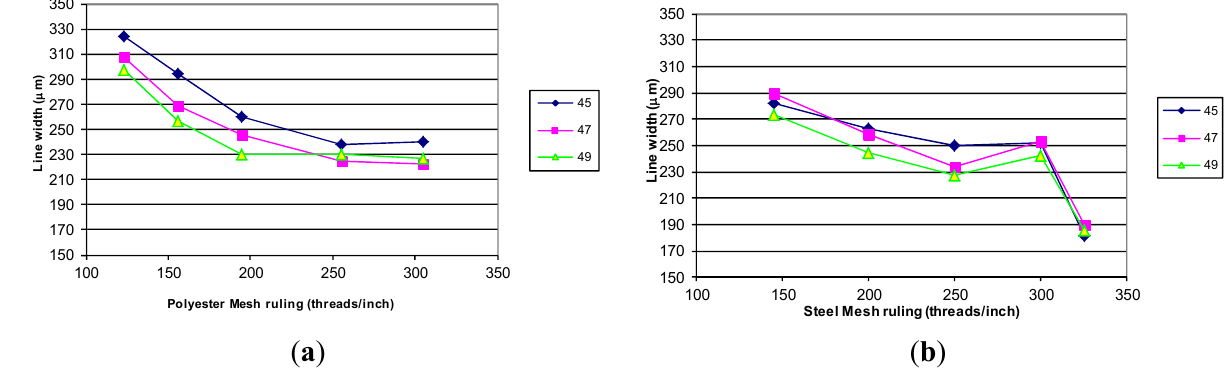
Figure 4 . The effect of mesh ruling on the cured printed line width of the polymers inks for a nominally 200 μ m line ( a ) polyester and ( b ) stainless steel meshes for each silver content.